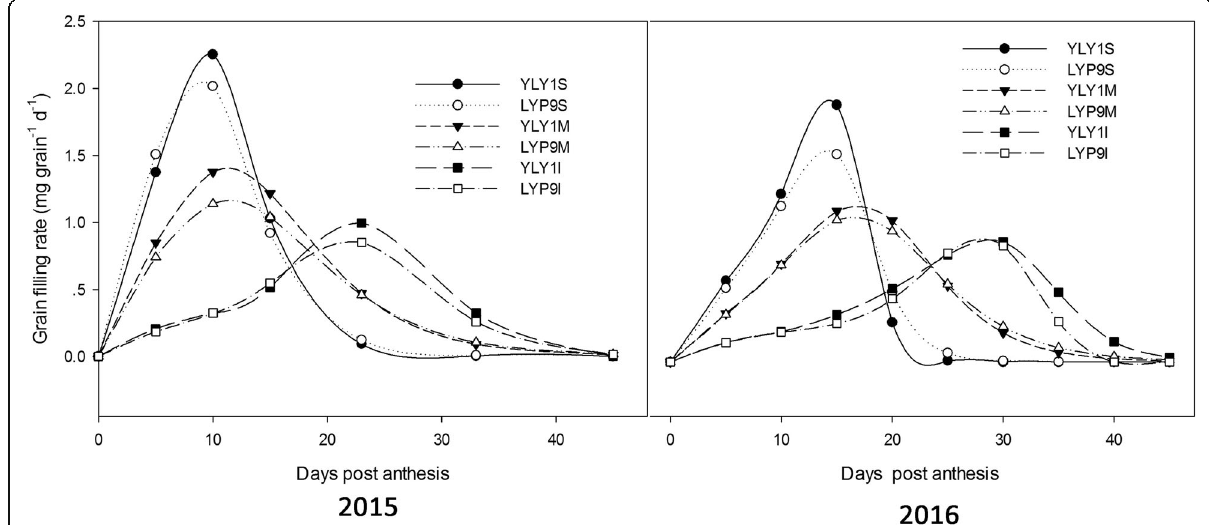
Fig. 9 The superior, middle and inferior grain filling rates after anthesis in 2015 ( a ) and 2016 ( b ). YLY1S represents superior grain of panicle in YLY1, YLY1 represents the middle grain in panicle of YLY1, YLY1I represents the inferior grain of panicle in YLY1. LYP9S represents superior grain of panicle in LYP9, LYP9 represents the middle grain in panicle of LYP9, LYP9I represents the inferior grain of panicle in LYP9. The bar represents the standard deviation of 10 replicates